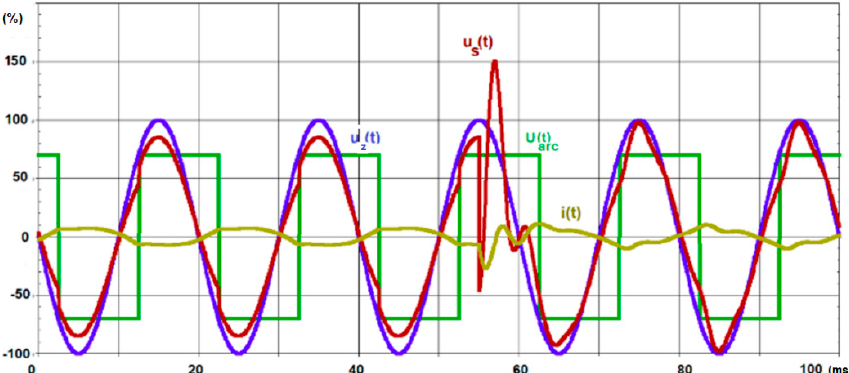
Figure 25. Waveforms of supply voltage u z (t), voltage on steel busbars u S (t) and voltage u arc (t) and furnace current i (t), switching on the capacitor banks.